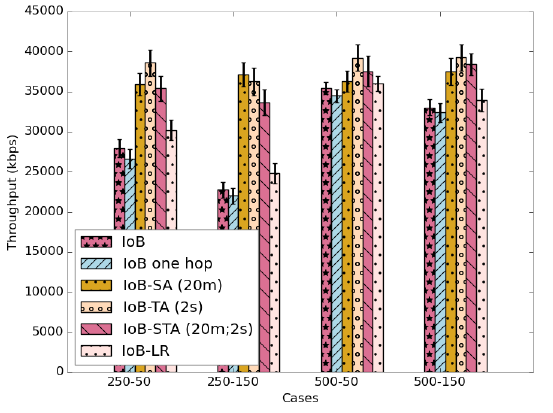
Figure 40. Average throughput comparison.